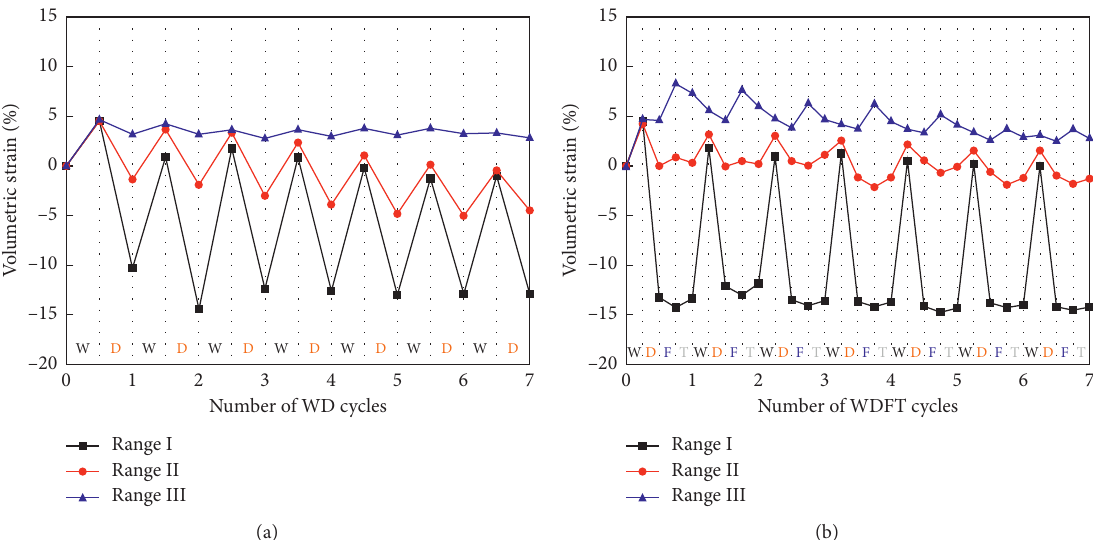
Figure 10: Curves of volume changes with cycles under different dry ranges. (a) Samples exposed to WD cycles. (b) Samples exposed to WDFT